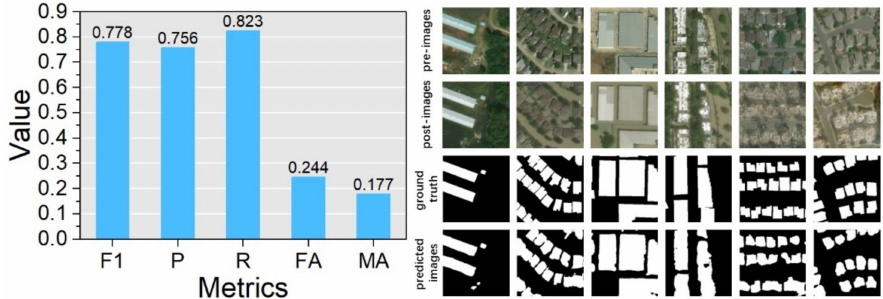
Figure 6. Histograms of model evaluation metrics and sample